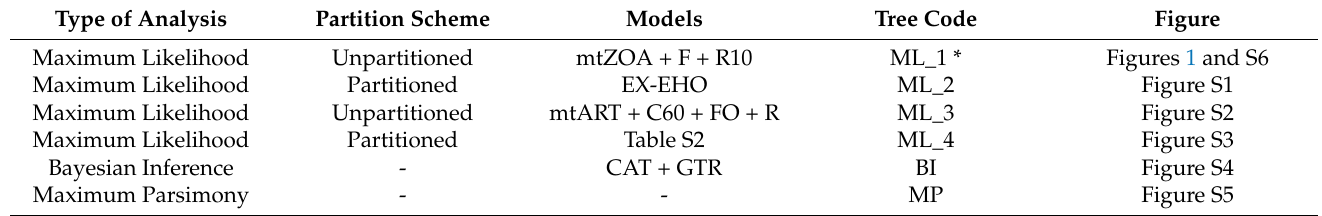
Table 1. Different types of analyses, partition schemes (for ML analyses), models, and respective tree codes used in this study and their respective resulting